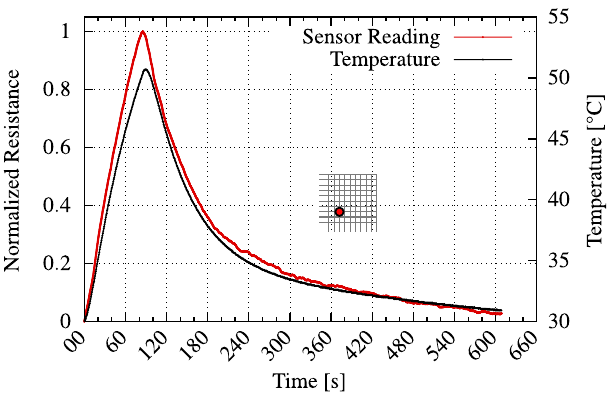
Figure 9. Output reading of sensor (2, 2) sampled at highest possible frequency. When sampling only a single sensor, thus avoiding all multiplexing and stabilization overhead, a high temporal resolution of 90 ms can be